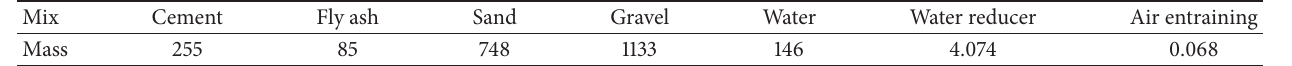
Table 1: Mix proportion of concrete (kg/m 3 ).